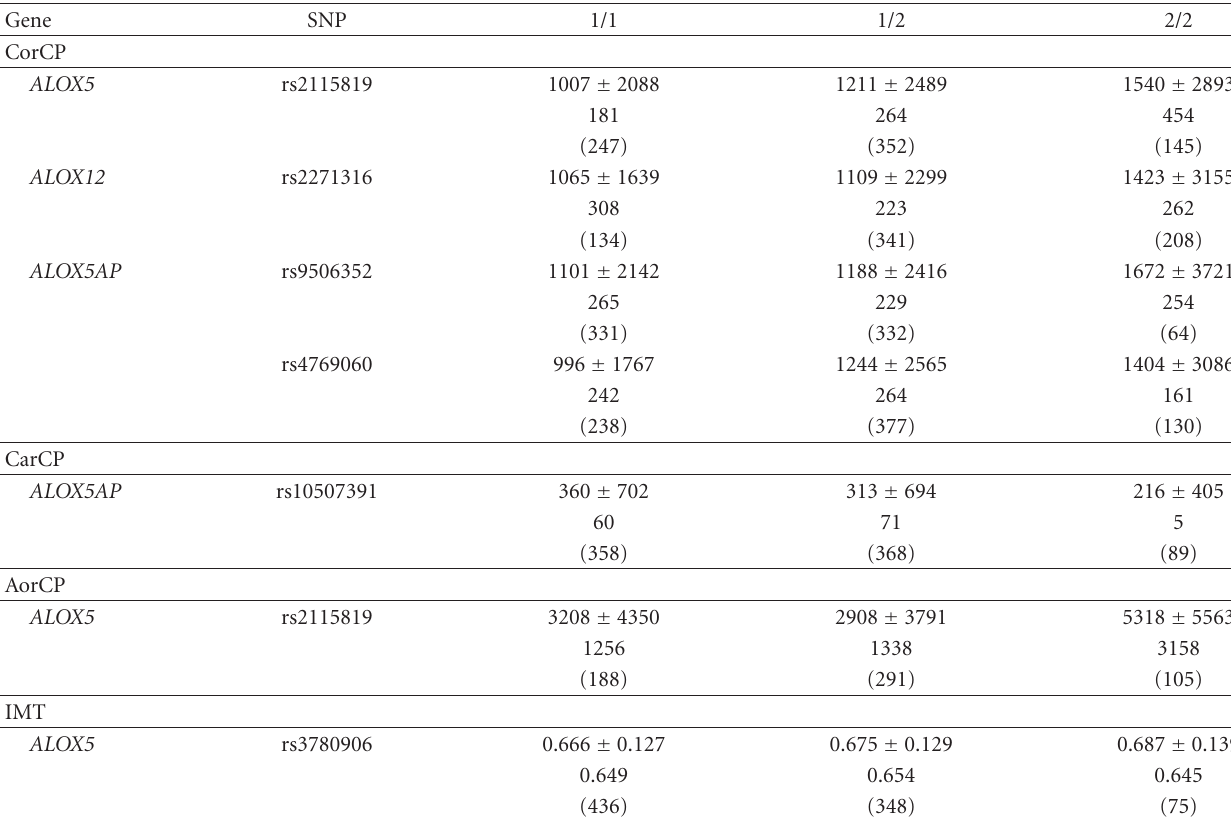
Table 4: Genotypic means ( ± SD) of lipoxygenase variants in ALOX5 , ALOX5AP, and ALOX12 with atherosclerosis phenotypes. Gene